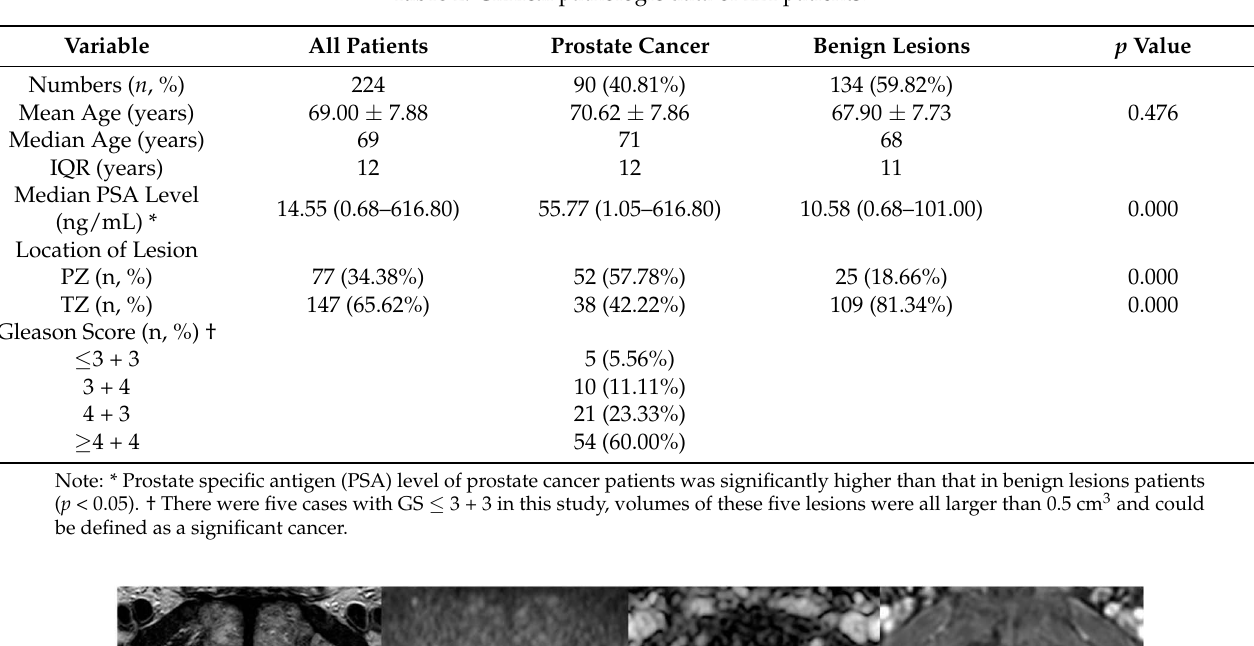
Table 2. Clinical pathologic data of 224 patients.